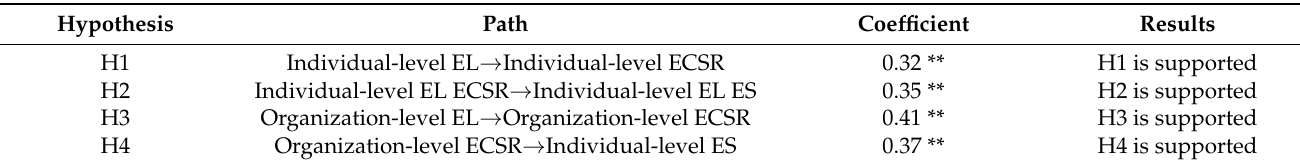
Table 4. Results of